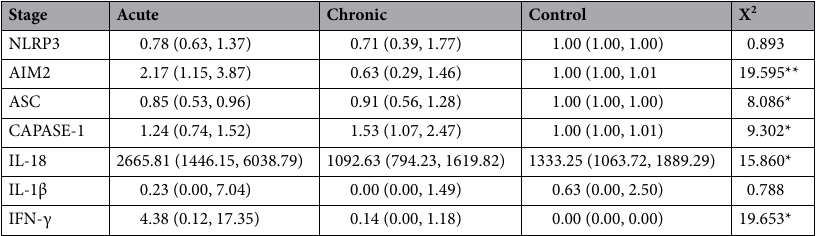
Table 3. Description and differences of gene expression levels (2−ΔΔct) and inflammatory cytokines (pg/ml) in each experimental group * P < 0.05 ** P <